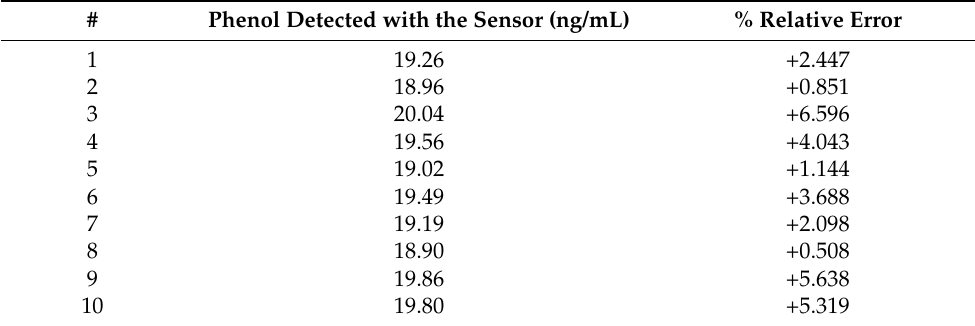
Table 6. Validation results from the recovery of phenol in lake-water samples containing 18.8 ng/mL